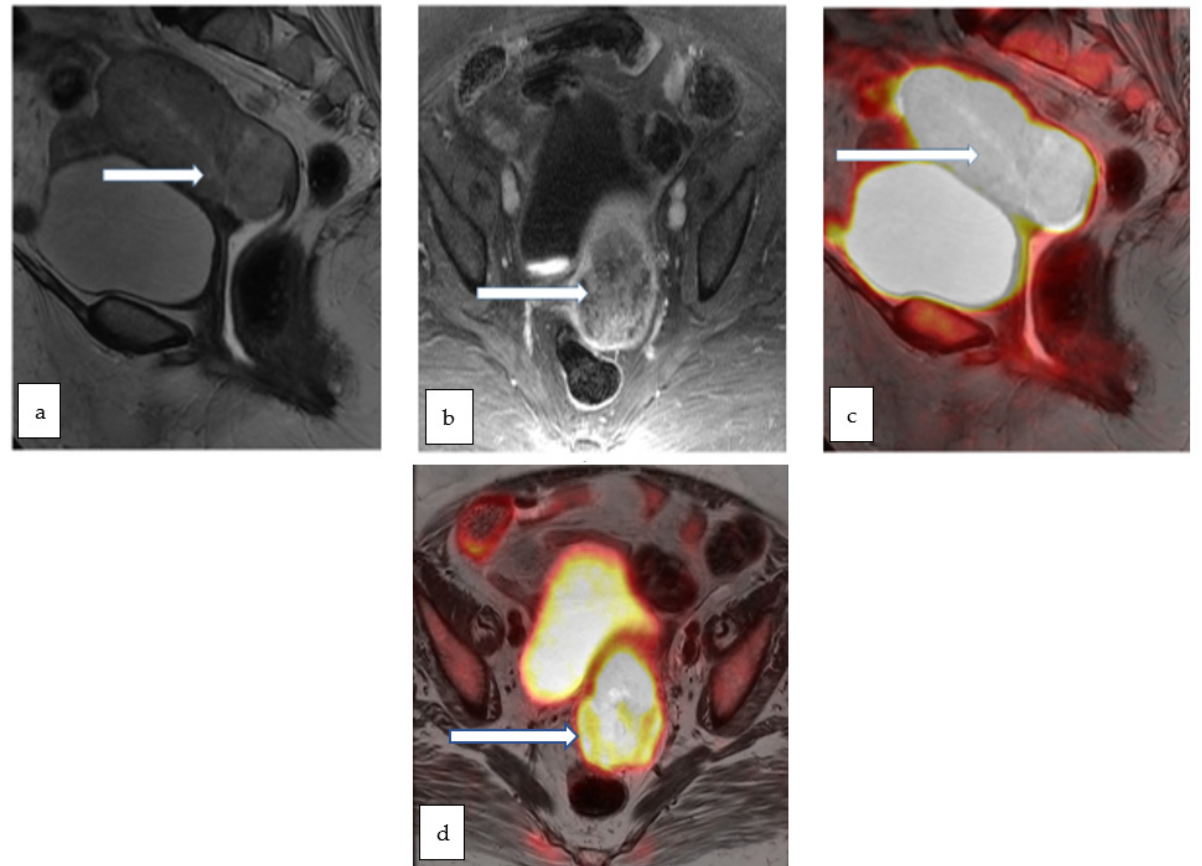
Figure 11. Sagittal T2 WI ( a ) and axial T1 post contrast ( b ) MR images in a 75 year old lady with post-menopausal vaginal bleeding and fatigue show a large heterogeneously enhancing infiltrative endometrial mass extending into the cervix. Corresponding sagittal ( c ) and axial ( d ) color fused PET/MR images show intensely hypermetabolic activity throughout the uterus including the cervix. Biopsy of the mass revealed high grade adenocarcinoma. Cervical cancer: PET-MRI potentially has a higher diagnostic sensitivity for local re- currence of cervical cancer than PET-CT. PET-MRI may also be of value in the detection